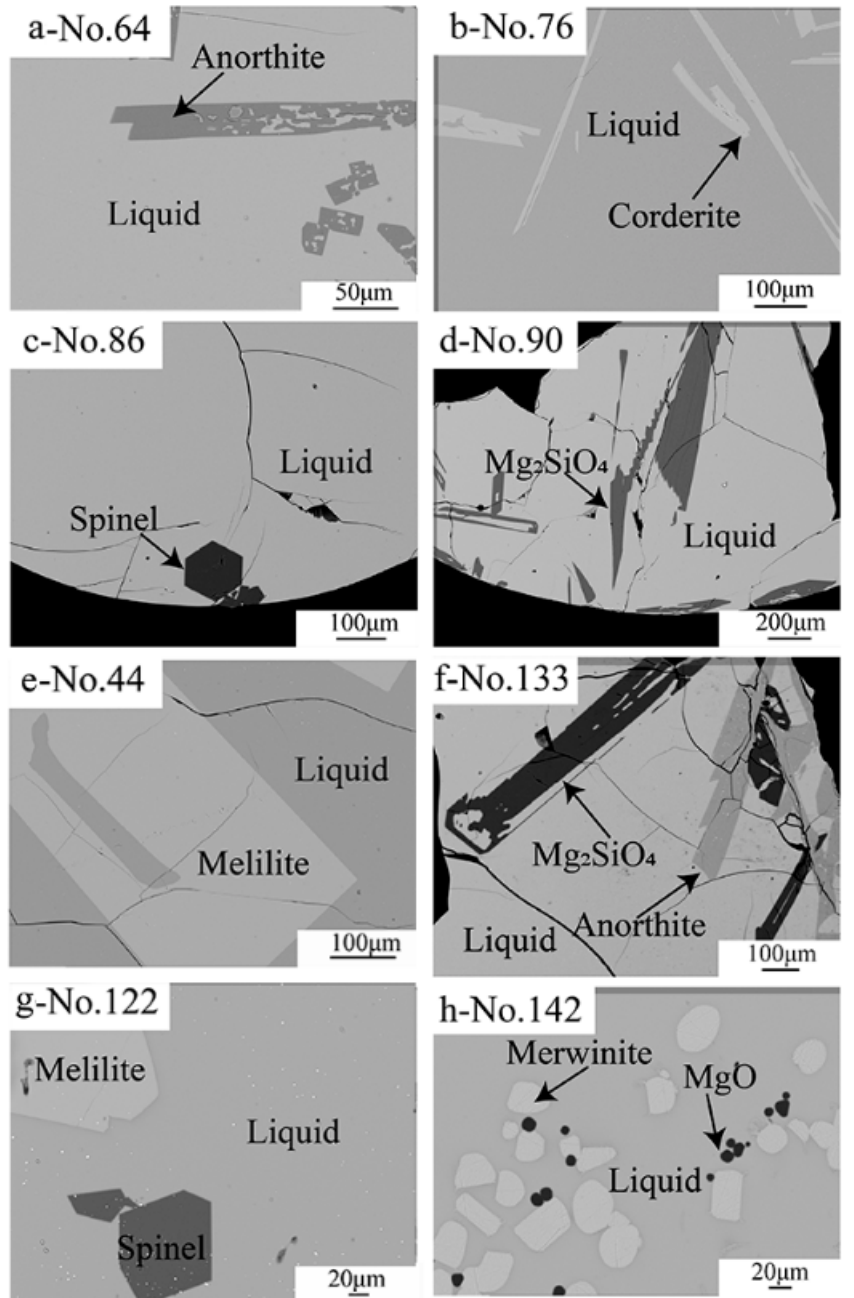
Figure 2. Typical backscattered SEM micrographs of the quenched slags showing the equilibrium of liquid with ( a ) anorthite, ( b ) cordierite, ( c ) spinel, ( d ) Mg 2 SiO 4 , ( e ) mellite, ( f ) Mg 2 SiO 4 and anorthite, ( g ) melilite and spinel, ( h ) MgO and merwinite.